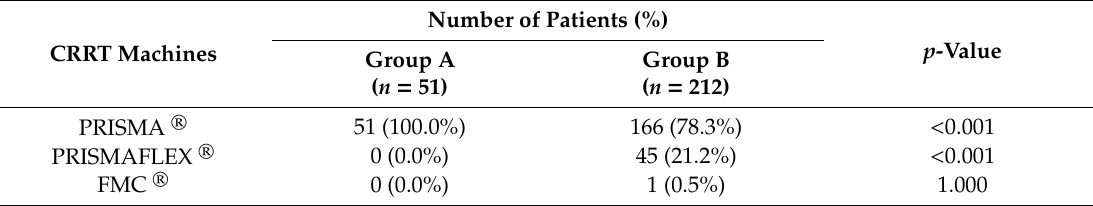
Table 6. Distribution of CRRT machines which used to patients.